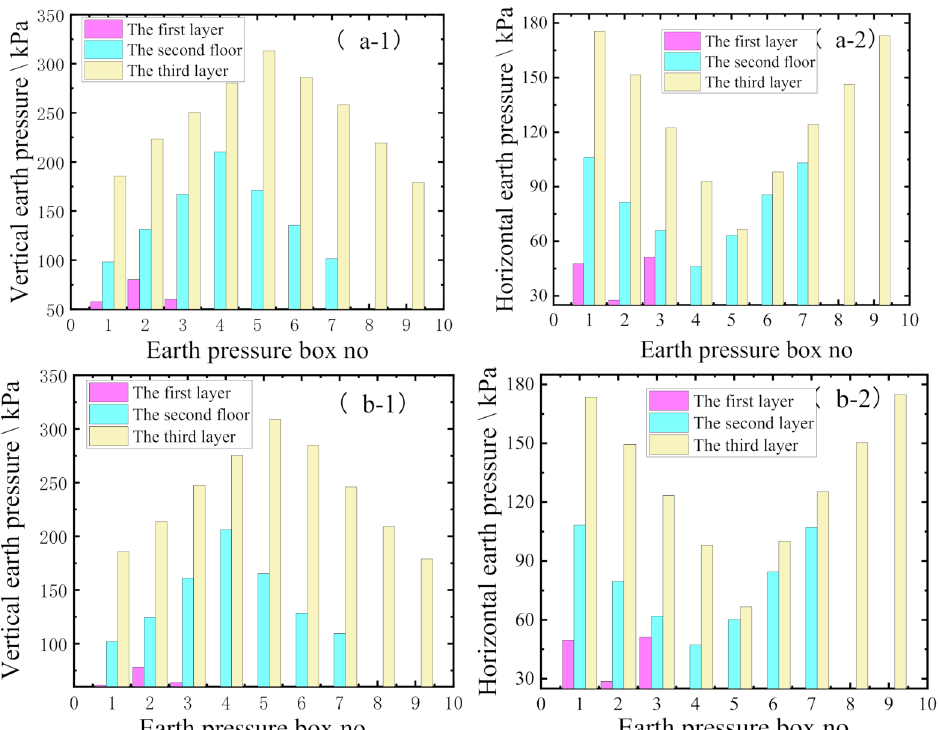
Figure 10. Vertical and horizontal earth pressure curves: ( a-1 ) the first group of vertical earth pressure; ( a-2 ) the first group of horizontal earth pressure; ( b-1 ) the second group of vertical earth pressure; ( b-2 ) the second group of horizontal earth